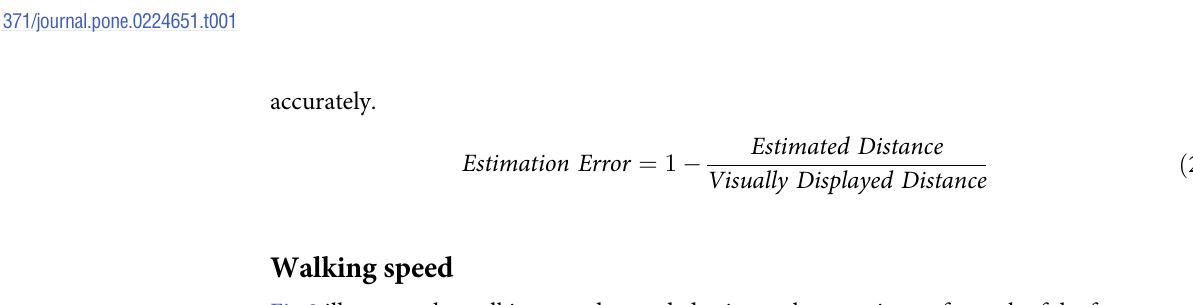
Results Results without Blind Triangulated Pointing